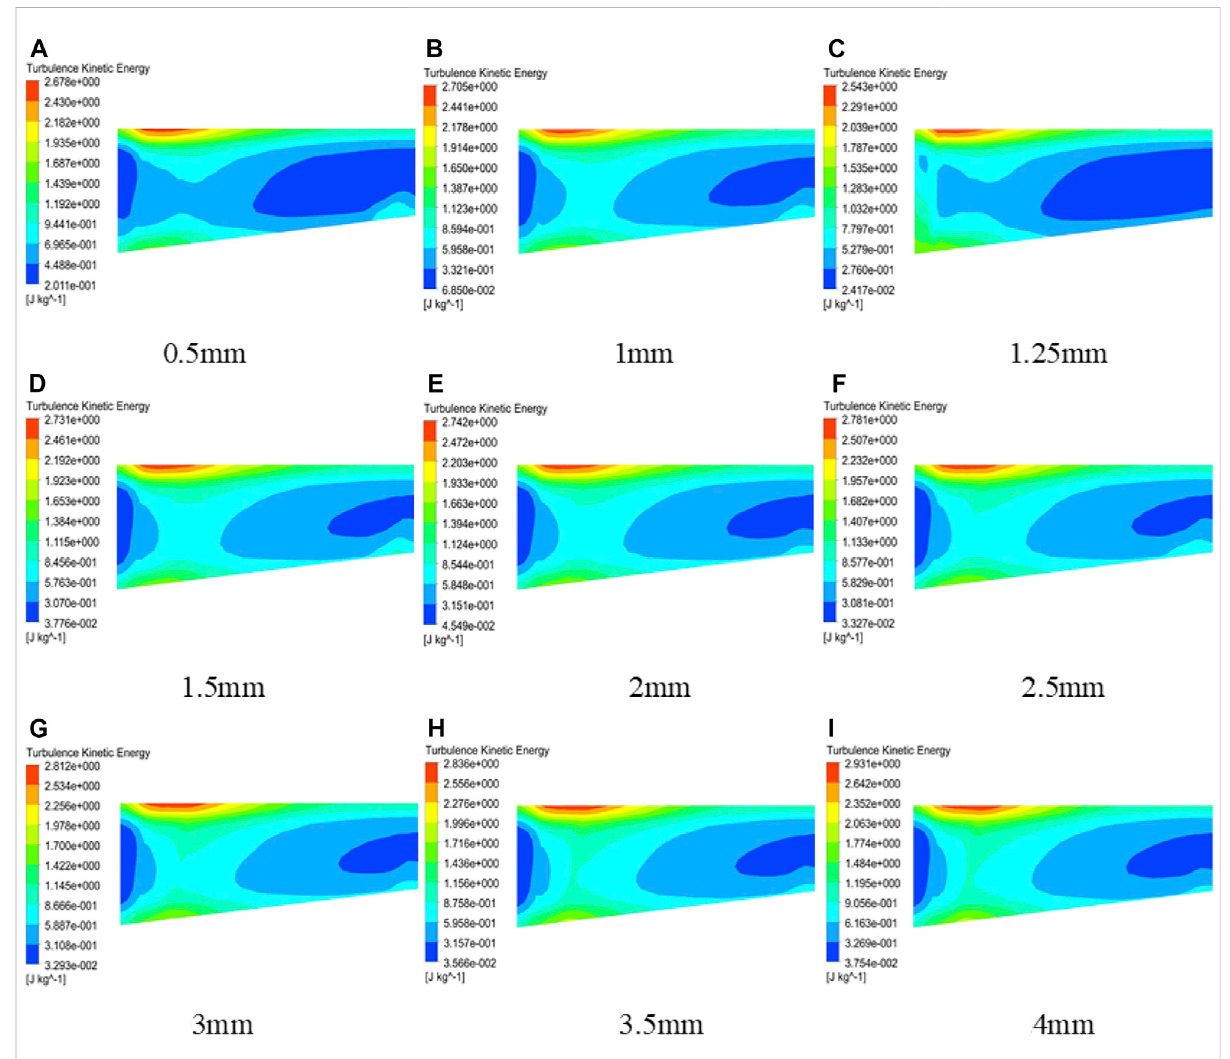
FIGURE 14 Distribution of the turbulent kinetic energy in the impeller passage with composite airfoils with different maximum thicknesses. (A) 0.5mm, (B) 1mm, (C) 1.25mm, (D) 1.5mm, (E) 2mm, (F) 2.5mm, (G) 3mm, (H) 3.5mm, (I)